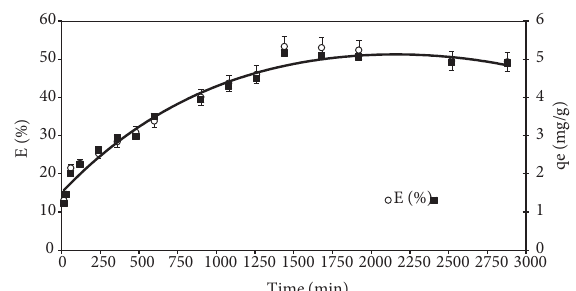
Fig. 2. Effect of contact time on Cu 2+ sorption onto waste